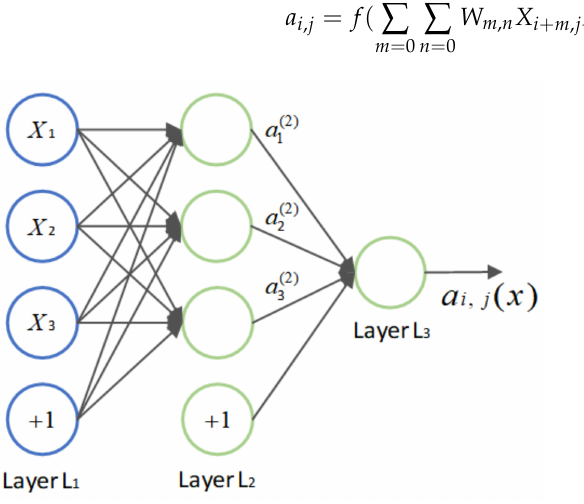
Figure A1. Structure of neural